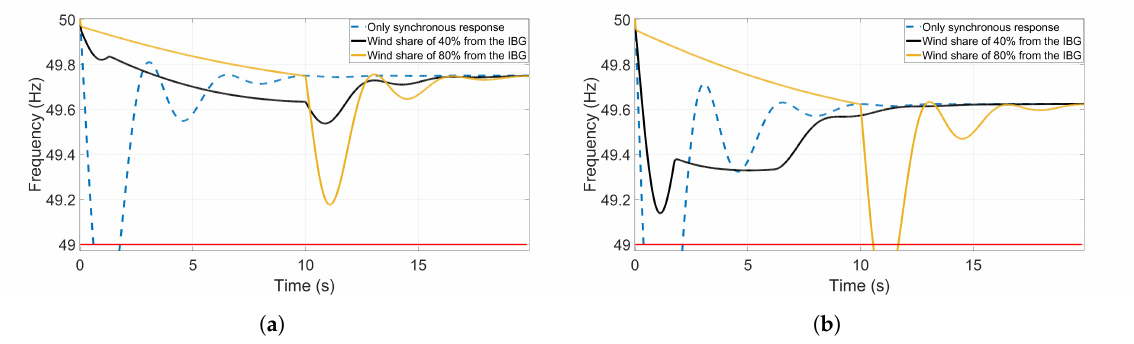
Figure 12. ( a ) System frequency response and synthetic inertia performance with a power imbalance of 10%. ( b ) System frequency response and synthetic inertia performance with a power imbalance of